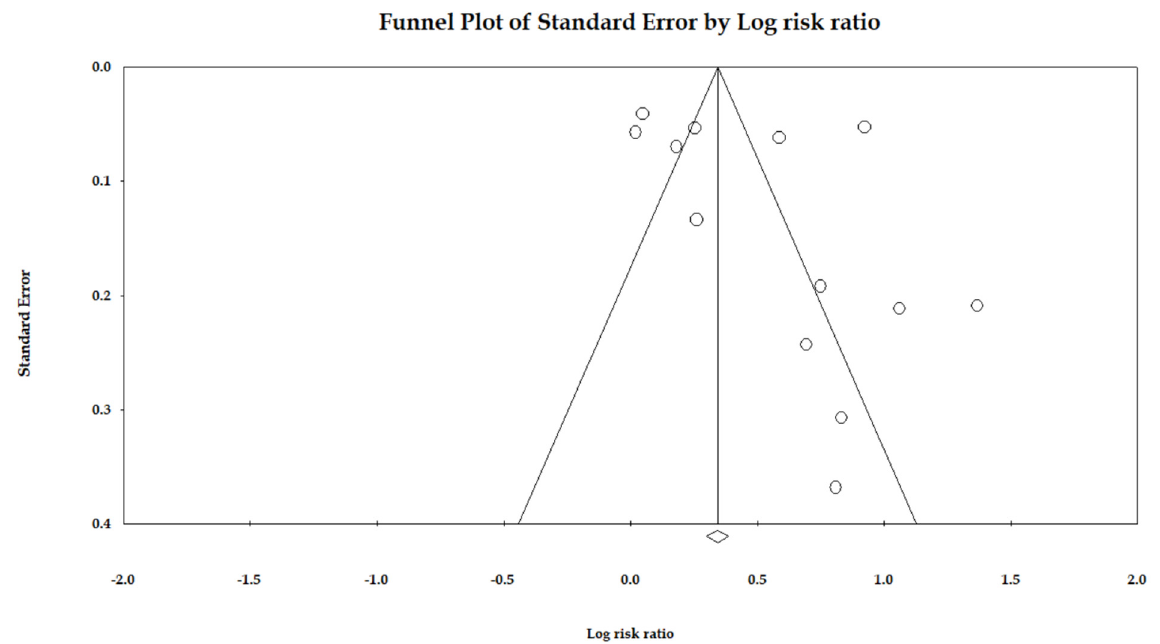
Figure 3. Funnel plot for the association between PPI use and the risk of acute kidney disease.